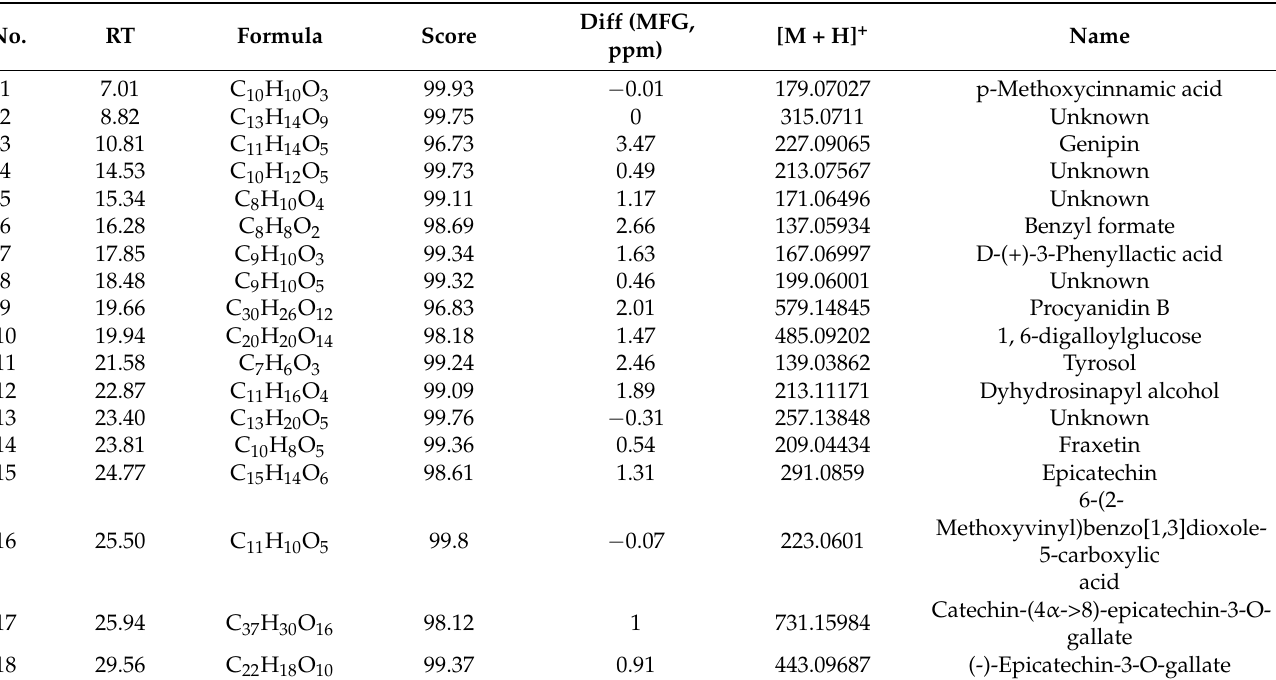
Table 8. Analytical results of a hydrothermal extract of A. tegmentosum using